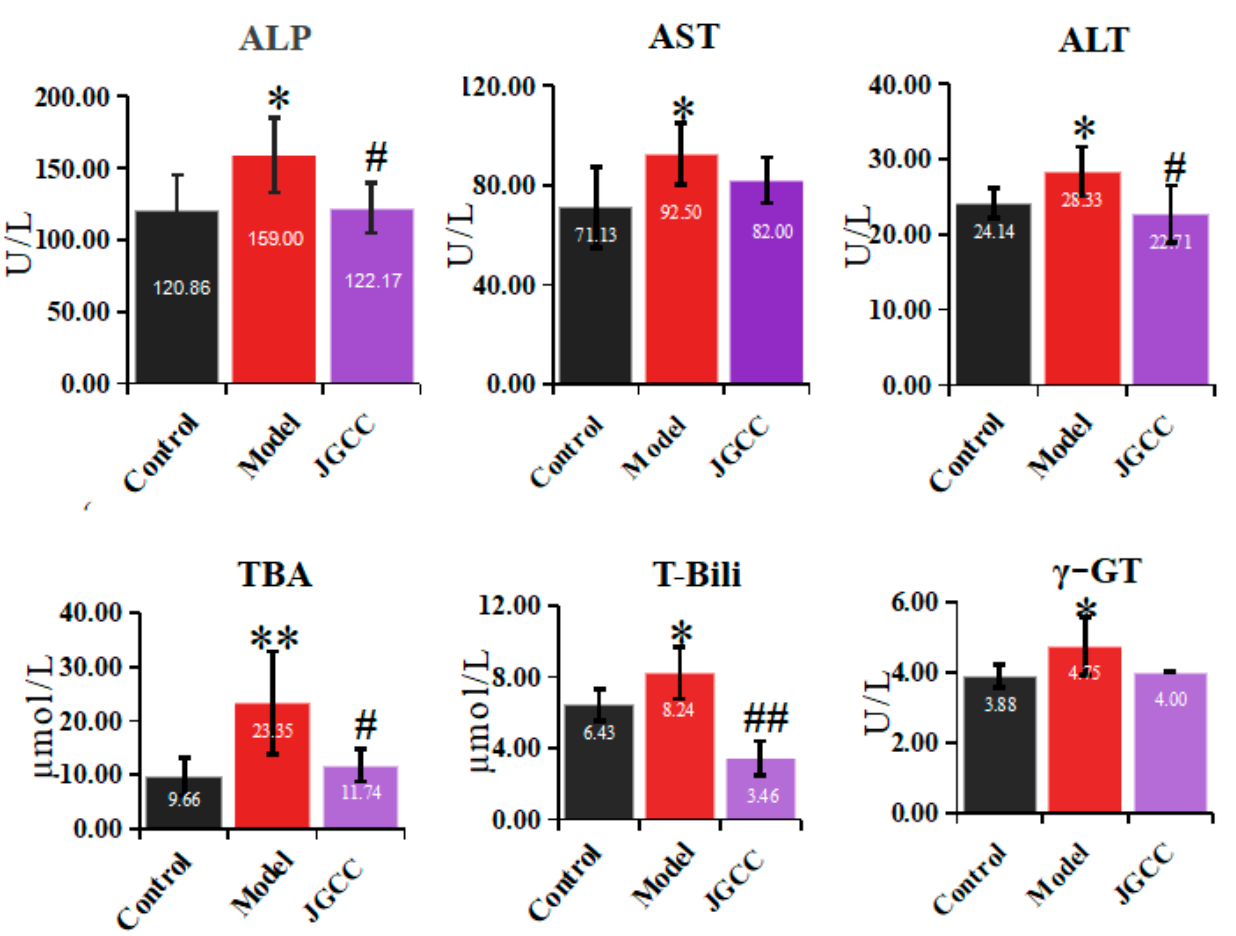
Figure 2. Determination results of biochemical indexes in different group vs. control group, * p < 0.05, ** p < 0.01; vs. model group, # p < 0.05, ## p < 0.01.